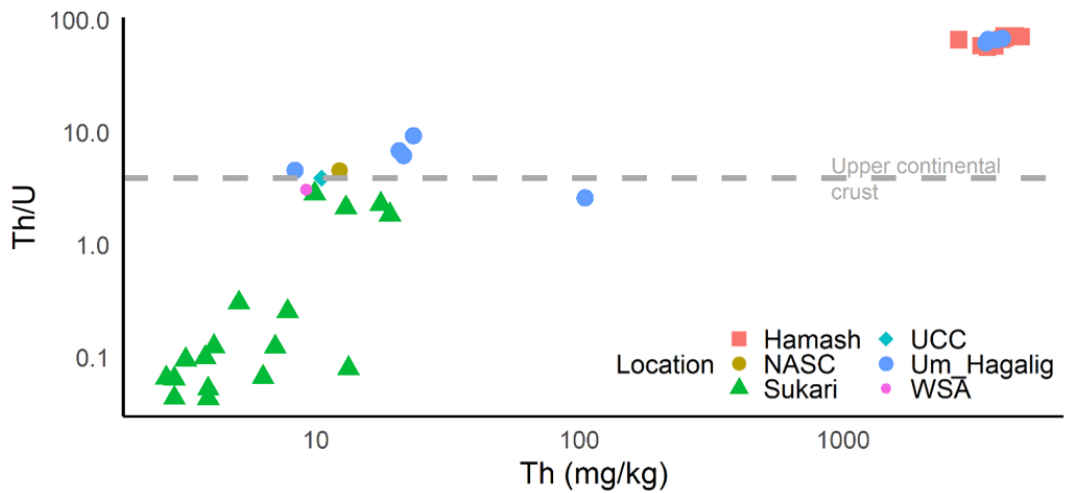
Figure 7. The biplot illustrating the relationship between Th/U vs. Th. For comparison purposes, the corresponding values reported by Rudnick and Gao [41] for upper continental crust UCC, Gromet, Haskin, Korotev, and Dymek [38] for North American shale composite NASC, Taylor and McLennan [40] for Post Archean Australia Shale PAAS, and Kabata-Pendias [39] for world soil average WSA.